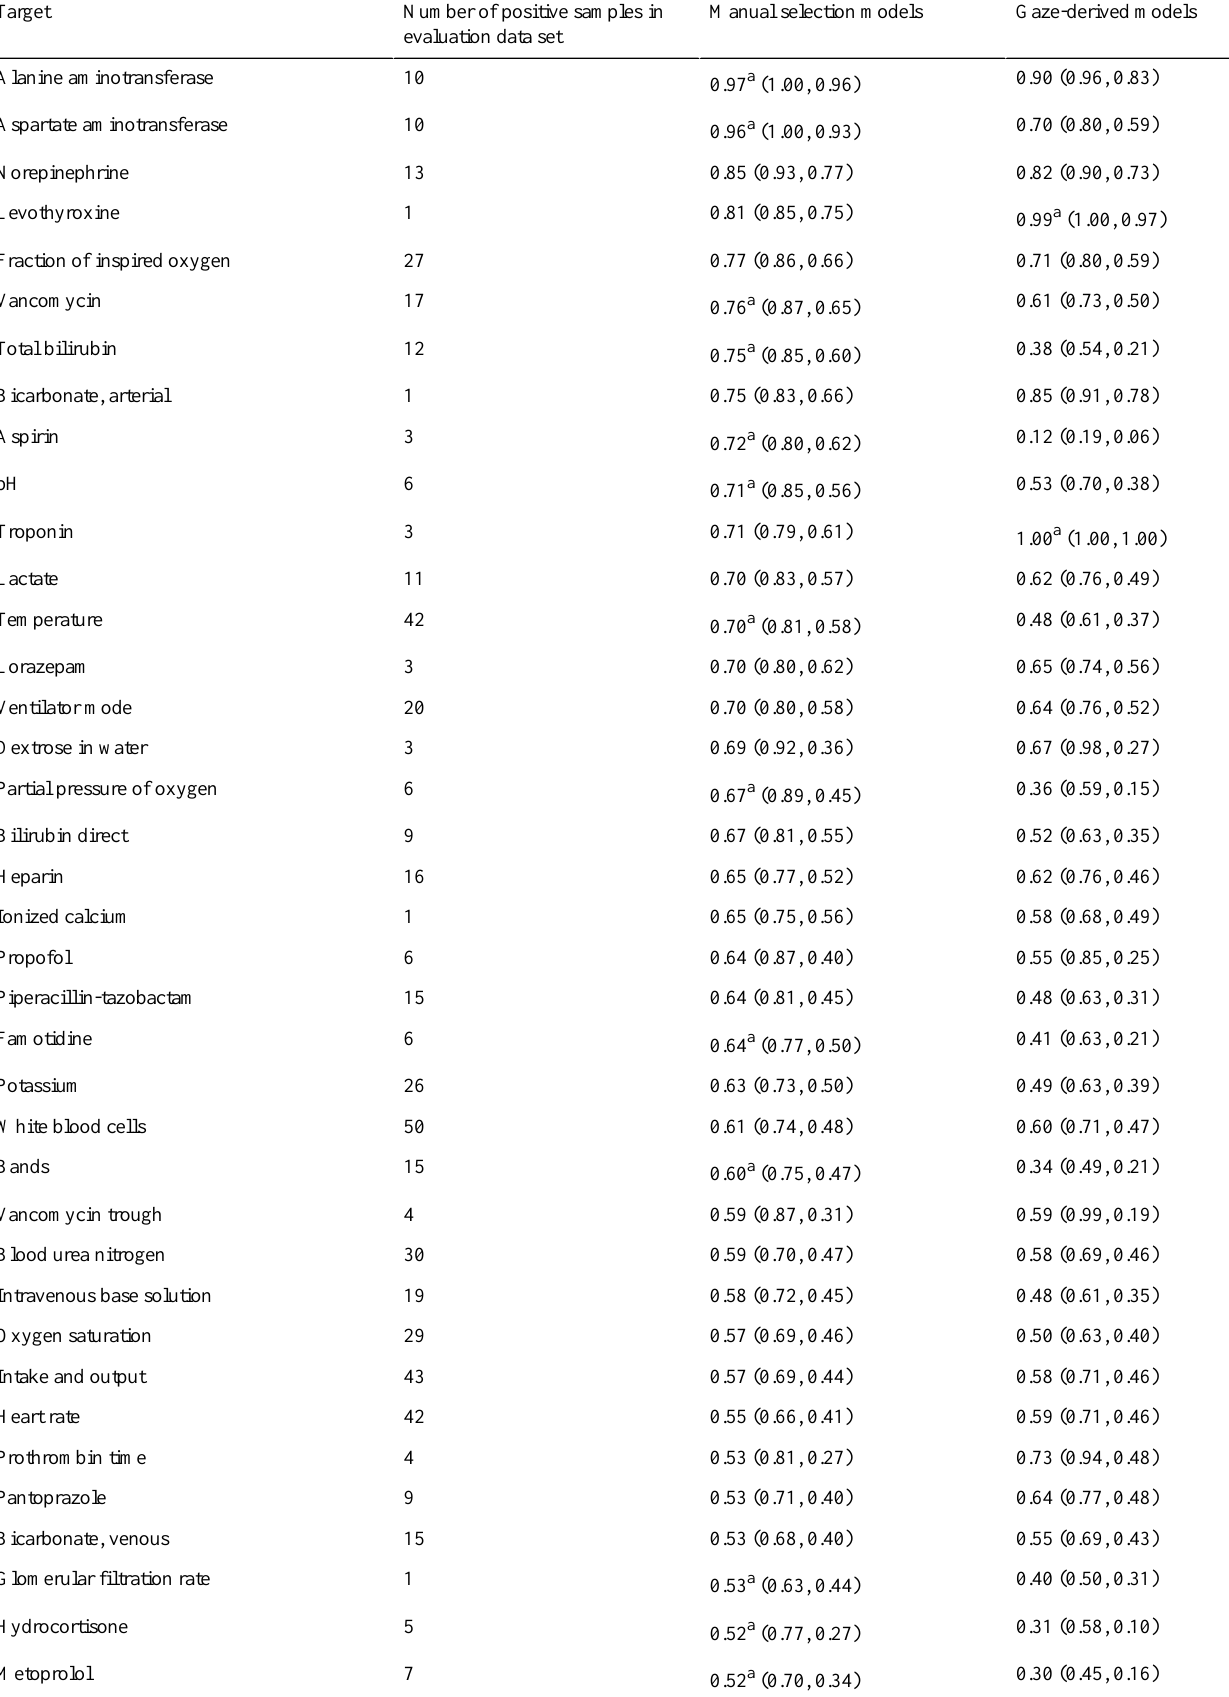
Table 4. Area under the receiver operating characteristic curve values (with 95% confidence intervals) on the evaluation data set of manual selection and gaze-derived models for predicting relevance of targets. Rows are sorted by manual selection